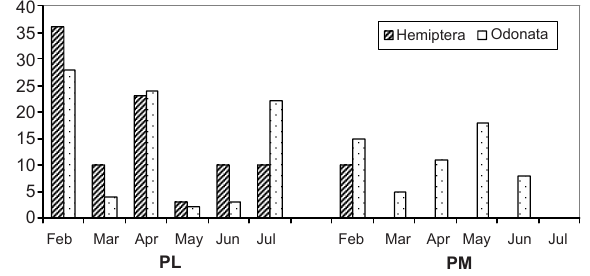
Figure 2. Temporal fluctuation of density (no./unit time) of two orders of insects around Phumdi Live (PL) and Phumdi Mixed (PM)